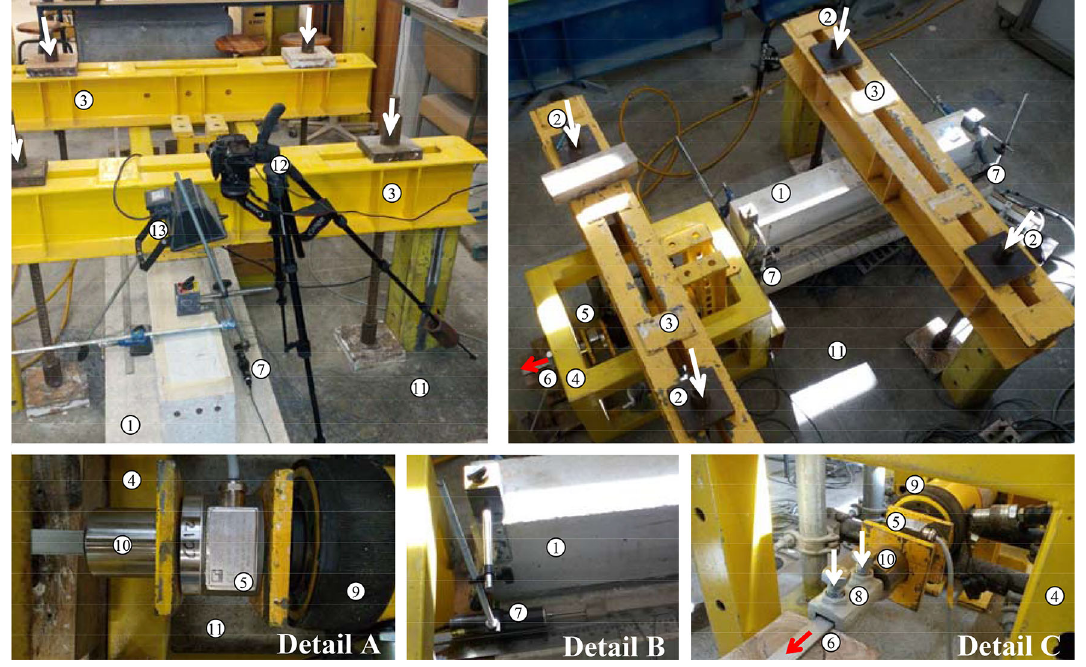
Fig. 3 Overview on the test apparatus